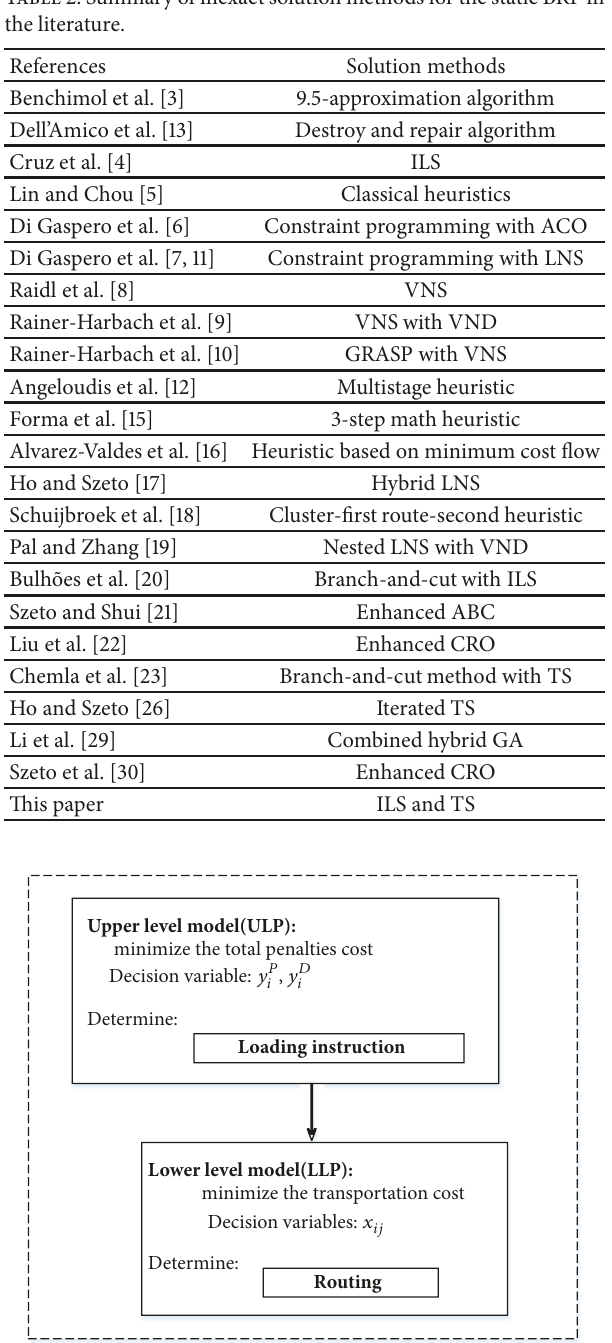
Figure 1: The conceptual structure of bilevel bike-sharing reposi- tioning